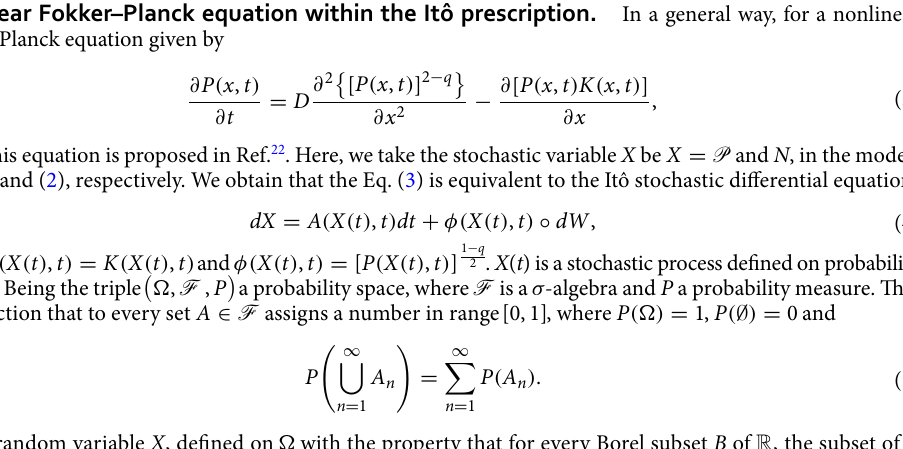
0 at range of large t →